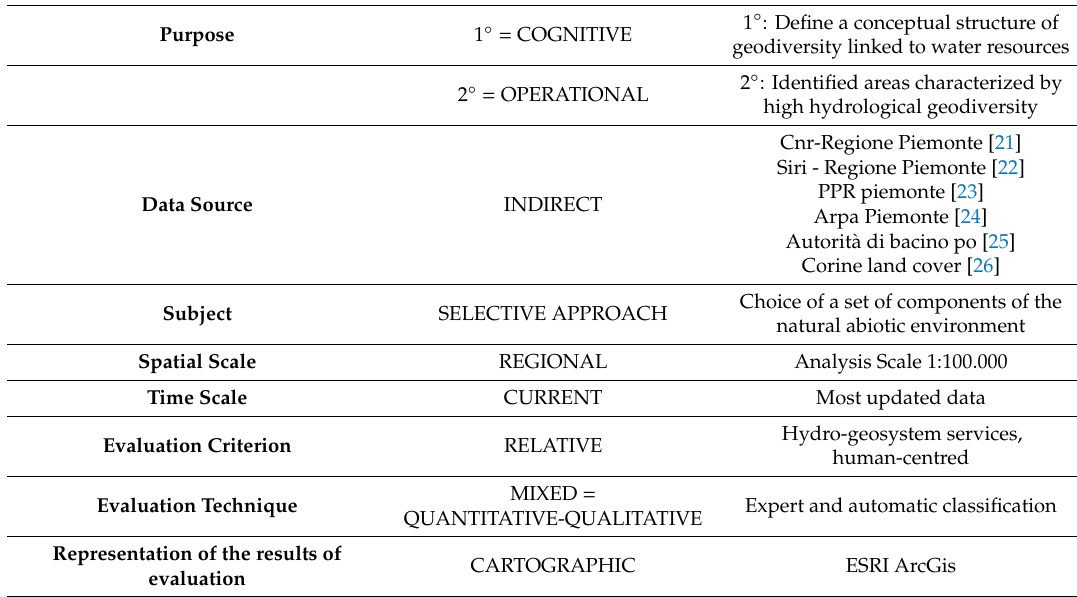
Table 1. Chosen parameters for hydro-geodiversity assessment in the case study area (modified from Zwolinski, Najwer, and Giardino, 2018)